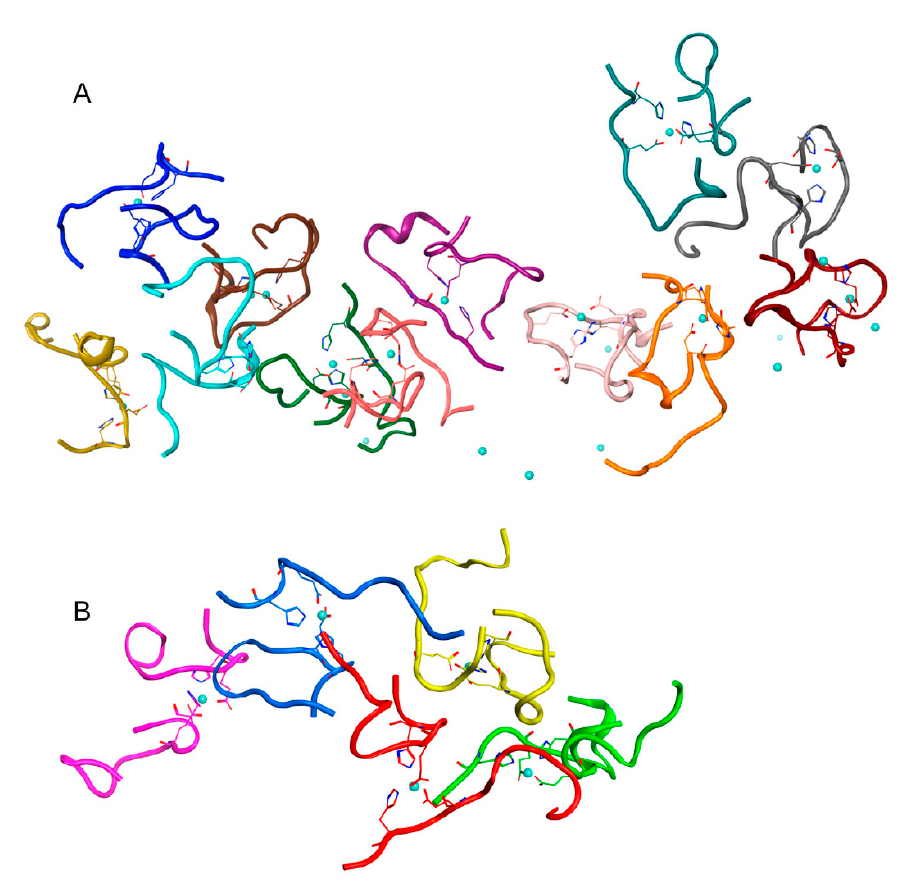
Figure 6. Results of 100 ns MD simulation of the Аβ 16 System 5 from Table 1 (C zn > C Аβ ). Two large clusters are shown ( A ), ( B ) Box size is 15 nm. The Аβ 16 molecules are shown with different colors. Zinc coordinating side chains are shown. Zinc ions are highlighted in blue.